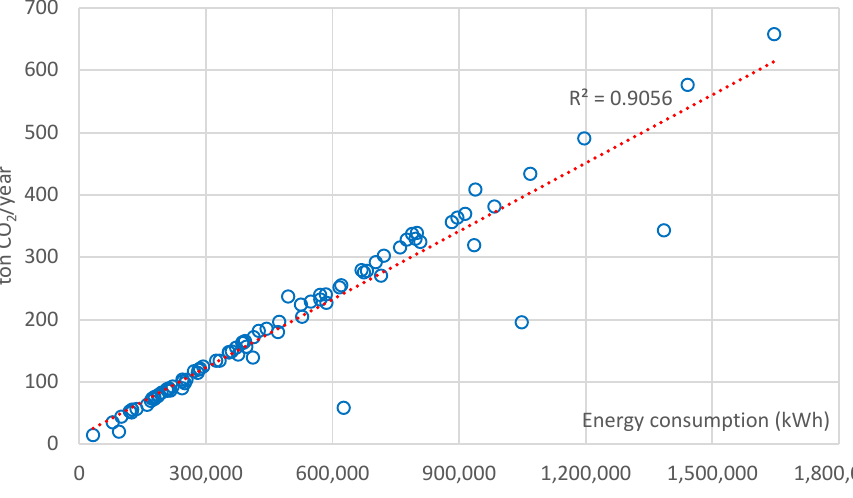
Figure 7. Average annual energy consumption of a municipality and its CO 2 emissions.